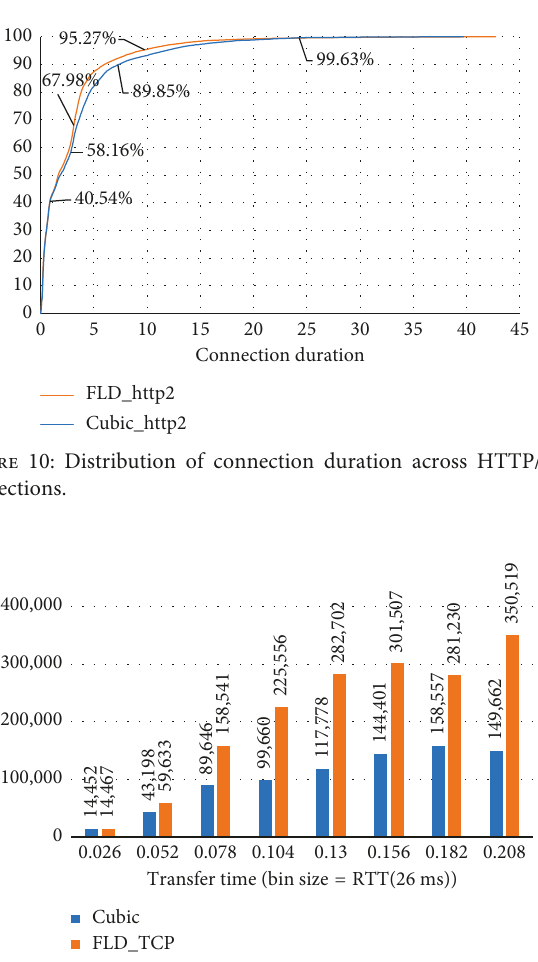
Figure 11: Maximum size of web objects transferred in each RTT bin.